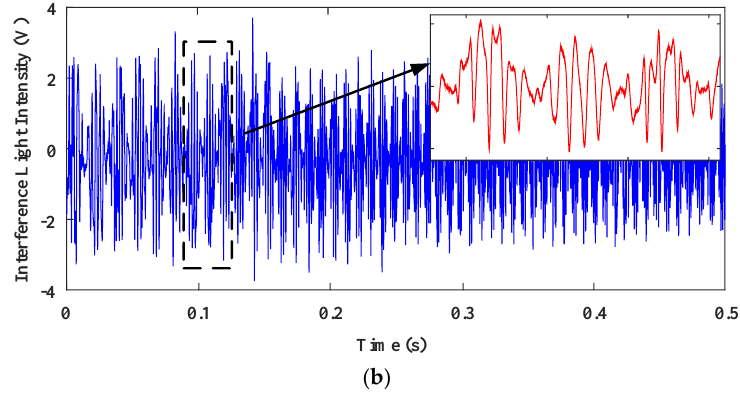
Figure 17. The interferogram signals acquired in time domain with look-up table control using the same driving as PID control. ( a ) Reference light. ( b ) Testing light.